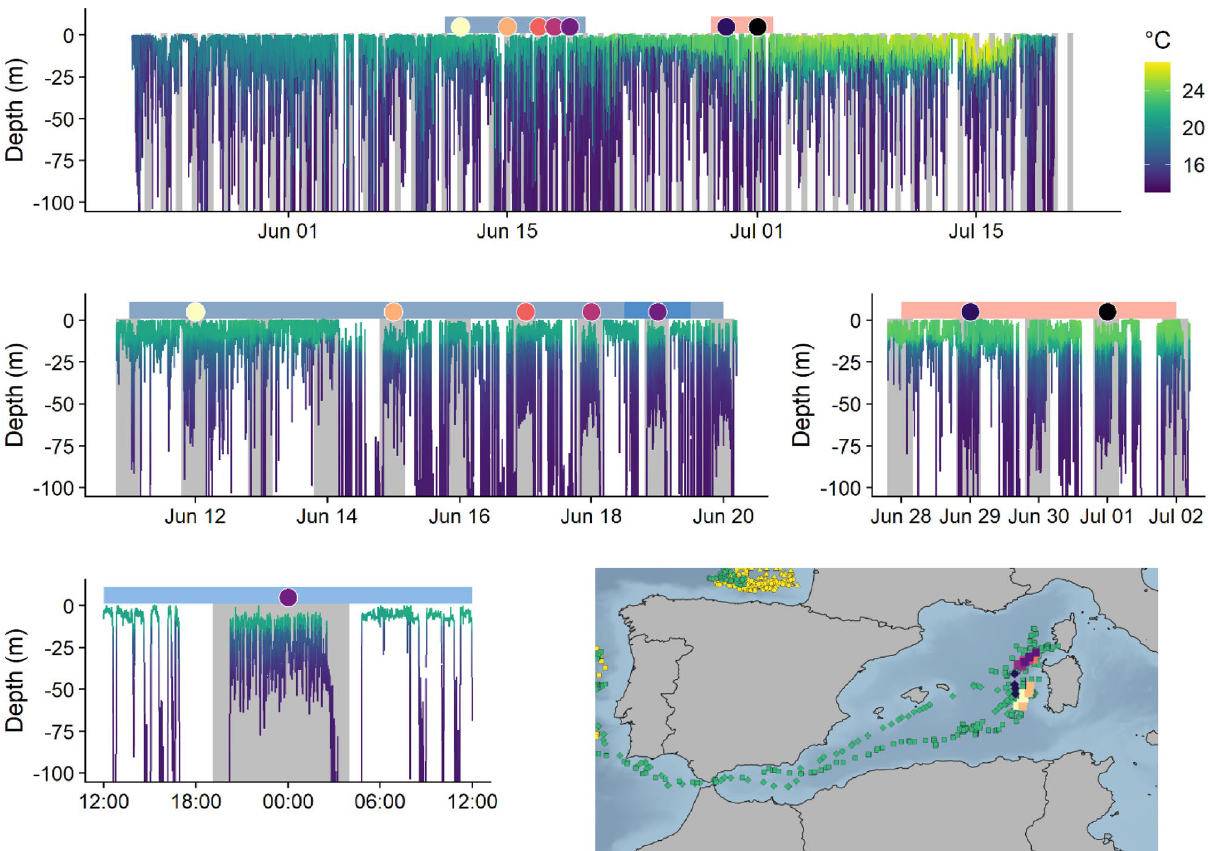
Figure 4. Putative spawning of a PSAT-tagged Atlantic bluefin tuna (34859), while in the Mediterranean Sea, in 2018. Upper panel shows depth and temperature during the entire period that the fish was in the Mediterranean Sea. Coloured bars above the graph in the top panel indicate the two periods presented in the middle panel. Coloured points indicate putative spawning events and corresponding locations are shown on the inserted map. A single putative spawning event is shown in detail in the bottom left panel. Bottom right panel show a subset of the modelled track overlaid with the dates spawning is identified with coloured dots (matching the colours in the upper